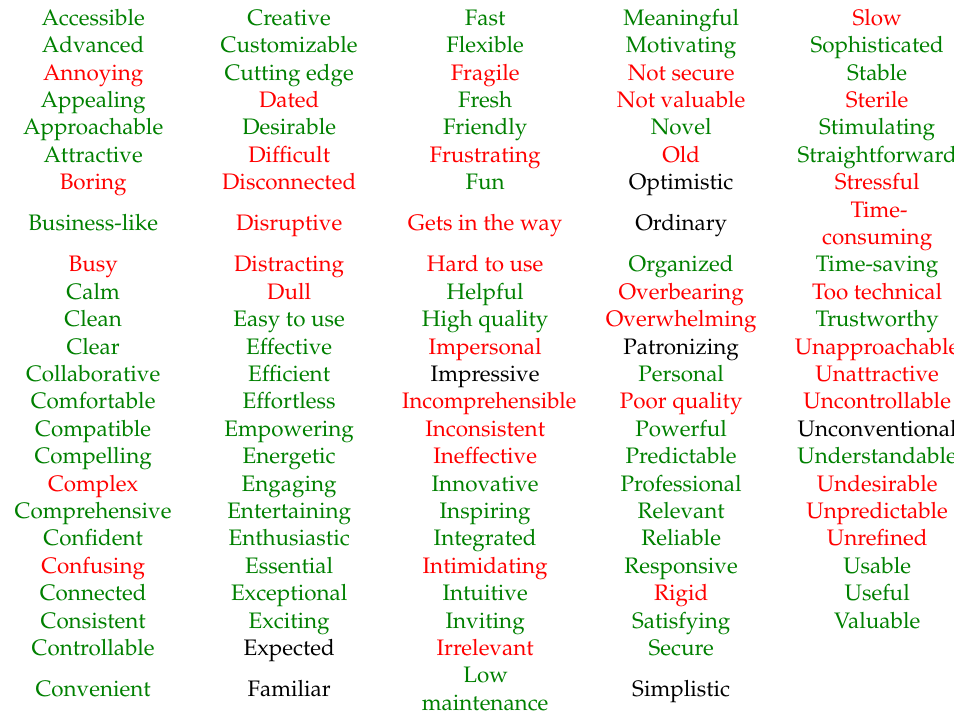
Table 2. The 118 words/multi-word expressions used in the 118-word test [58,62]. The words we considered as positive, neutral, and negative, in the context of our home assistant, are indicated using green, black, and red,